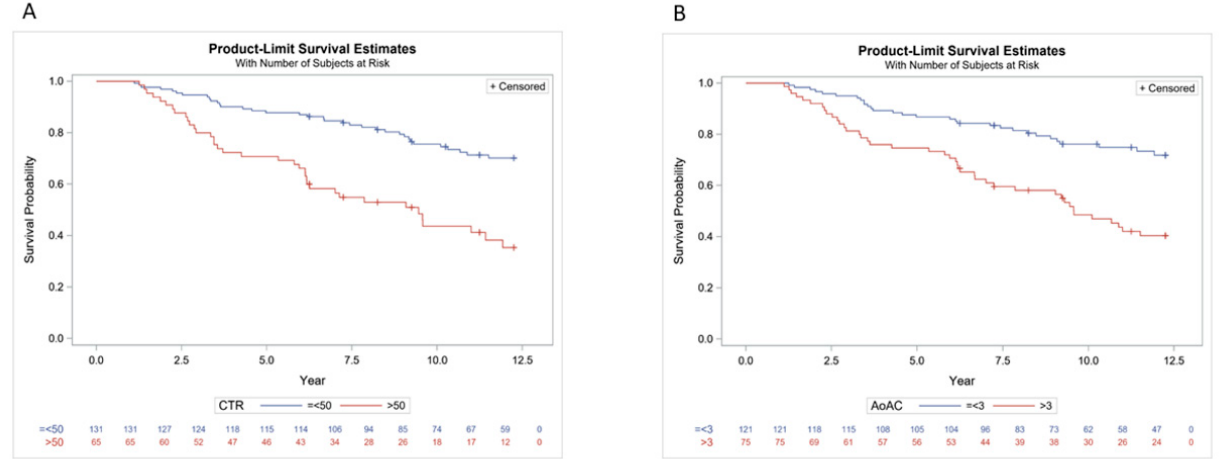
Figure 5. Kaplan–Meier analysis of CV mortality according to ( A ) CTR > 50% or ≤ 50%, and ( B ) AoAC > 3 or ≤ 3 in study patients (all log-rank p < 0.0001).